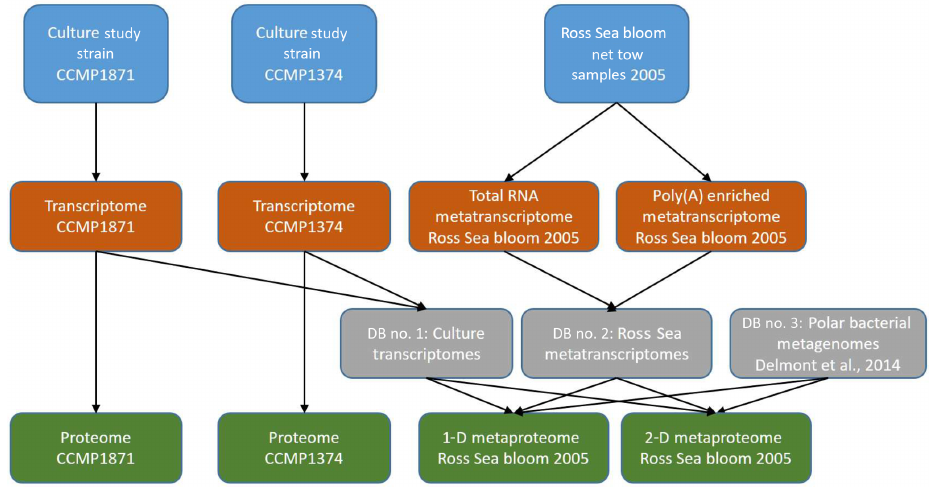
Figure 2. Experimental workflow used in this study. Culture and field samples (top), transcriptome analyses (second row), sequence database construction for proteomics (third row), and proteomic and metaproteomic analyses (bottom row).